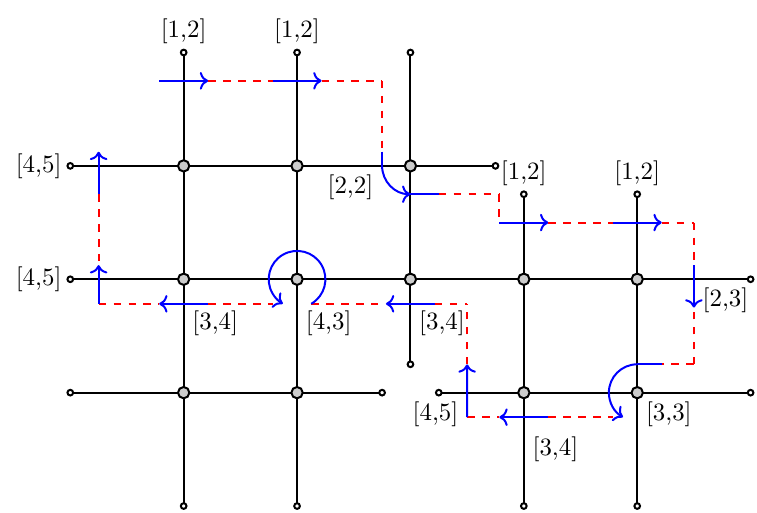
Figure 10 . We deform the contour inside the graph. Algebraically this means that we change C the monodromy. Blue segments denote Lax operators in the product. We see that we can always apply the transformations of the (cid:12)gure 9 to any part of this intermediate contour and thus shrink it further eventually reducing it to a point (i.e. the identity